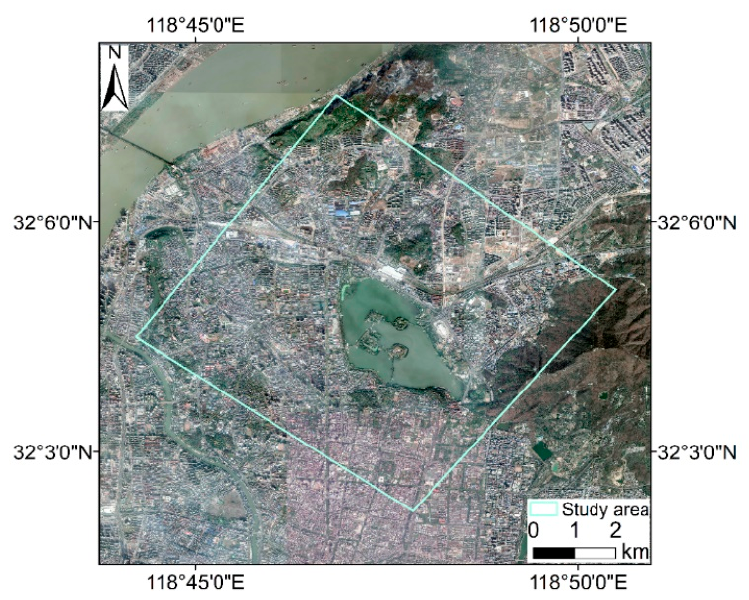
Figure 1. JL1-3B image range of study area without geometric correction (base map: Google Earth).